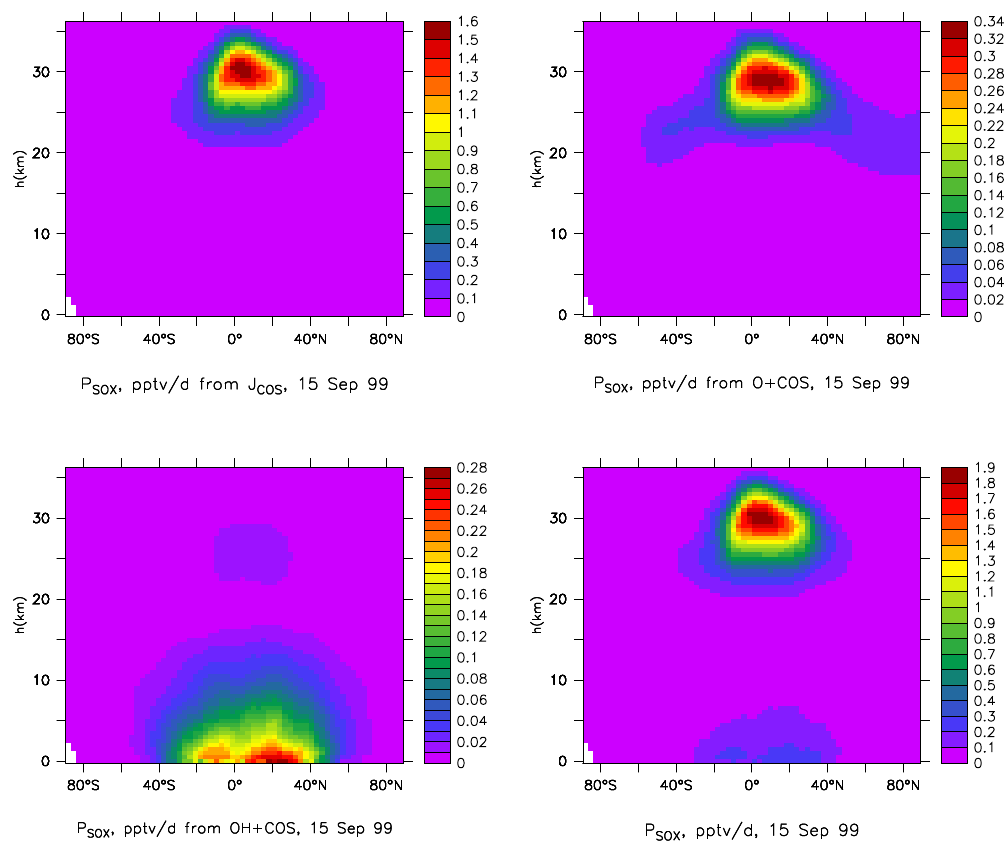
Fig. 3. SO x production from COS, pptvday − 1 , September 1999 (SO x =SO 2 +SO 3 +SO+SH+S). Upper left: photolysis, upper right: reaction with O( 3 P), lower left: reaction with OH, lower right: